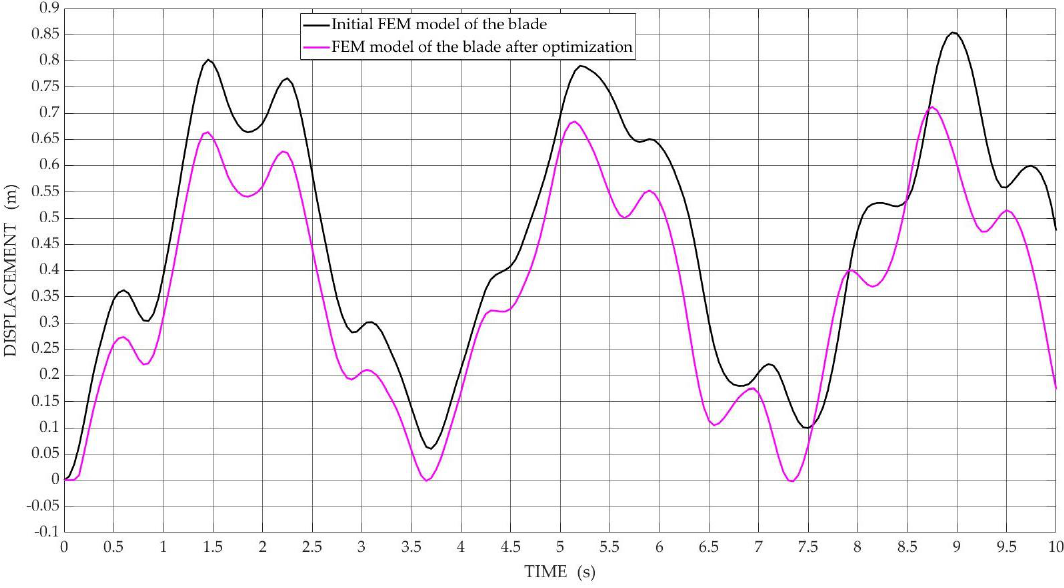
Figure 7. The diagram of vibration displacements in the transverse direction is determined in the node located in the middle of the blade span for the initial FEM model and the FEM model after optimization.